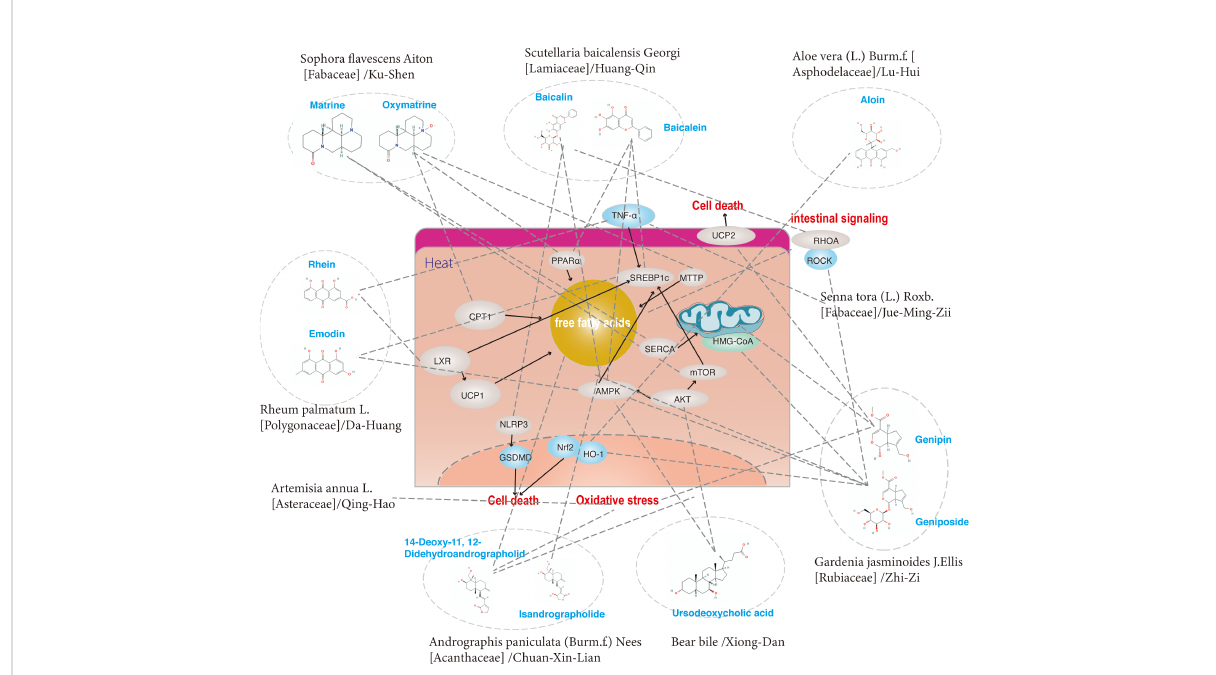
FIGURE 5 The regulatory effects on pathways induced by a group of ingredients from Heat-Clearing (Qing Re)